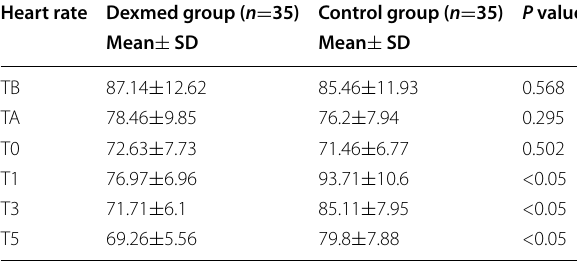
Data expressed as mean (SD). P value was significant if < 0.05. TB , baseline; TA , 5 min after study drug infusion; T0 , 3 min after induction and prior to